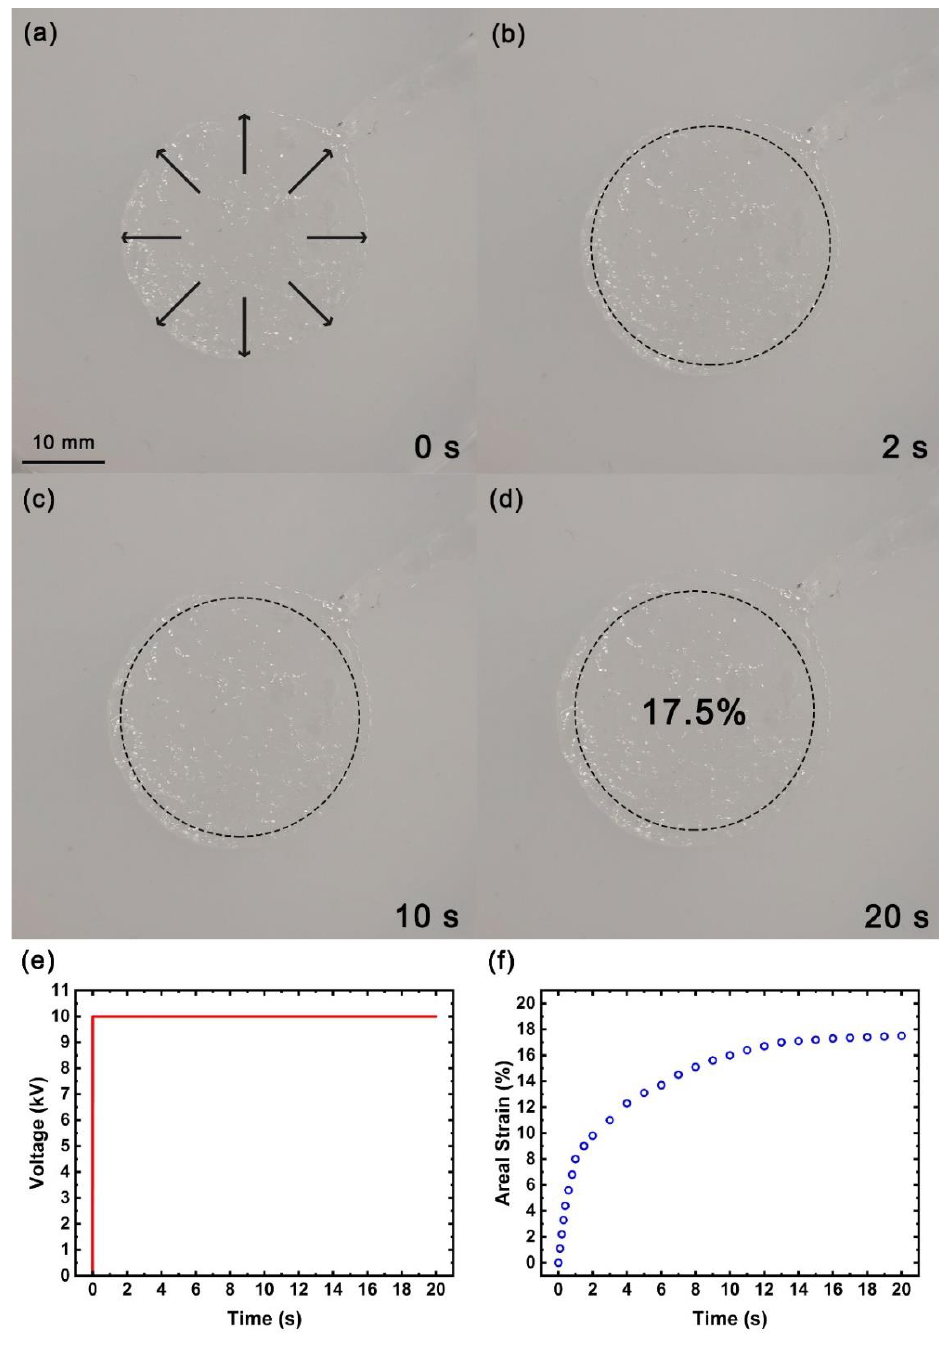
Figure 9. Flexible actuator based on PAM conductive hydrogel electrodes. ( a – d ) When a voltage was suddenly applied and subsequently held constant, the actuator expanded in the area over time; ( e ) waveform of suddenly applied external voltage; ( f ) the area strain measured at 20 s after the voltage was